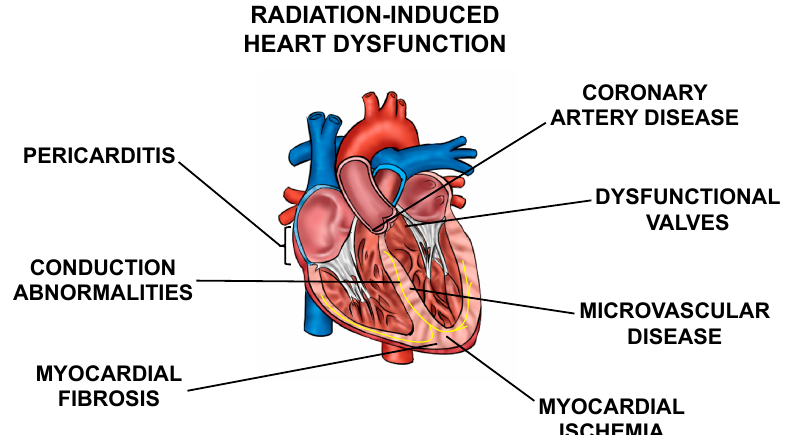
Figure 1. Cardiac radiation exposure causes a number of abnormalities. Exposure of the heart and surrounding vasculature to radiation may lead to several adverse structural and functional changes in the heart, in this article collectively referred to as radiation-induced heart dysfunction.